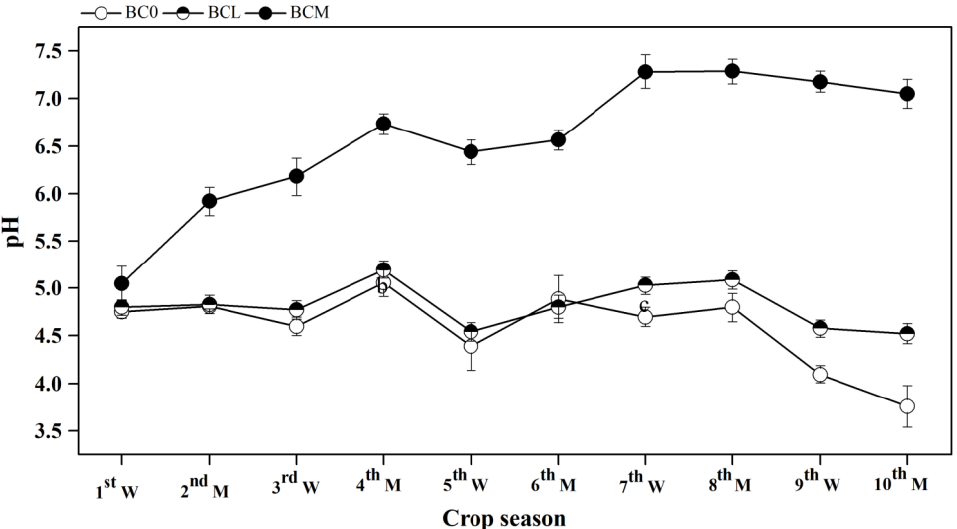
Figure 2. Changes in pH value in the red soil affected by successive applications of straw biochar during 10 consecutive wheat/millet growing seasons from 2010 – 2015. Error bars are standard deviations.